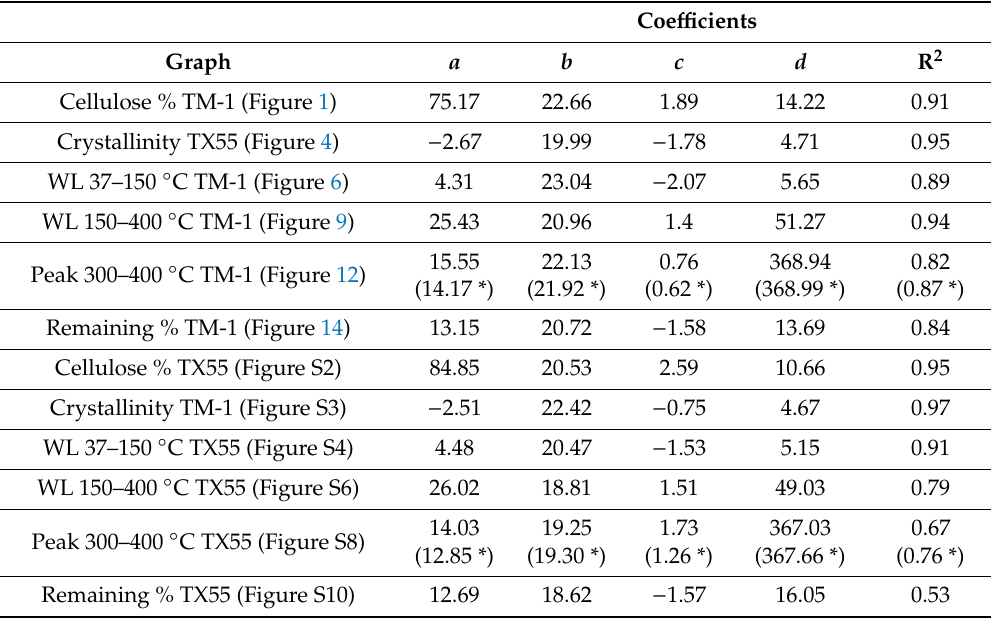
Table 2. Fitting coe ffi cients and fit statistics for the sigmoid curves.